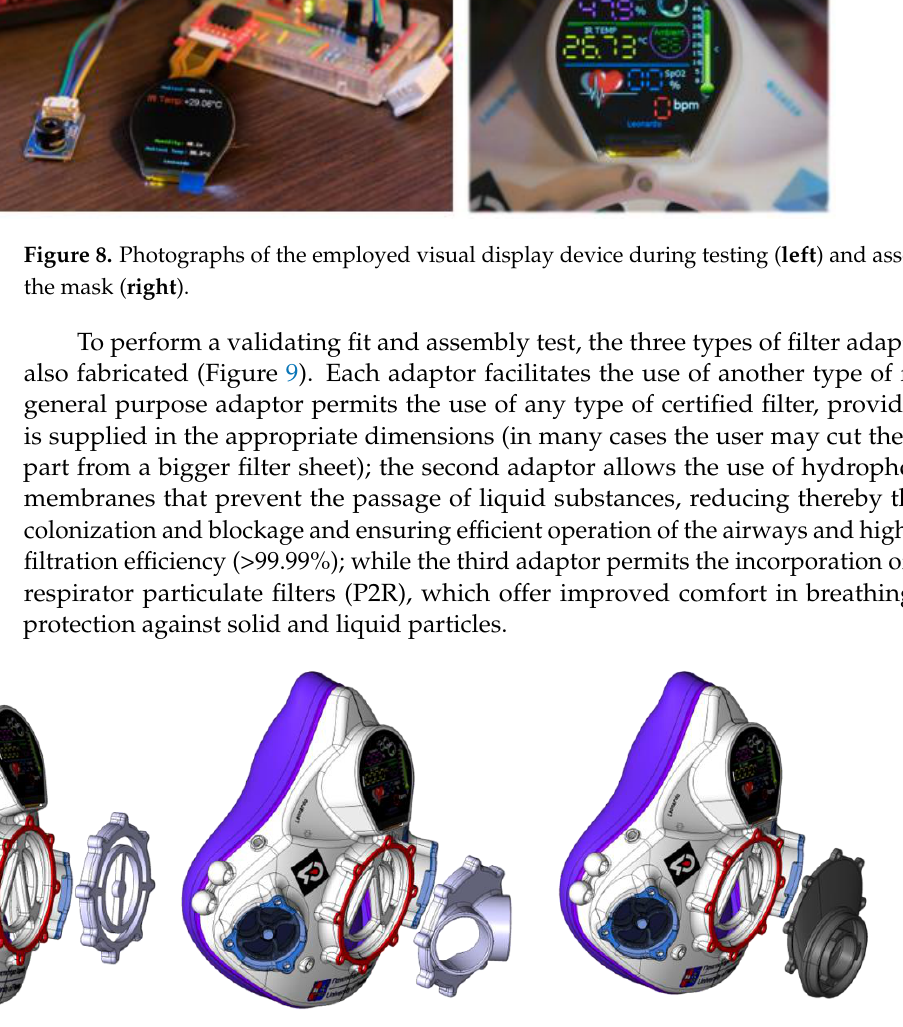
Figure 9. CAD representations of the mask equipped with the three adaptors ( left to right ): the general-purpose adaptor, the hydrophobic membrane filter adaptor, and the particulate filter adaptor. To test the fitness of masks on the corresponding faces, the two mask prototypes were fitted on the corresponding faces; the male mask prototype was directly tried on by the corresponding individual, while the female prototype was fitted on the corresponding physical face model. In both cases a very good fit between the mask and the face has been observed. In terms of time, the post processing required approx. 30 min; 20 min for clean- ing and inspection of MJ parts and 10 min for assembly of the whole mask and incorpo- ration of electronics and filters.